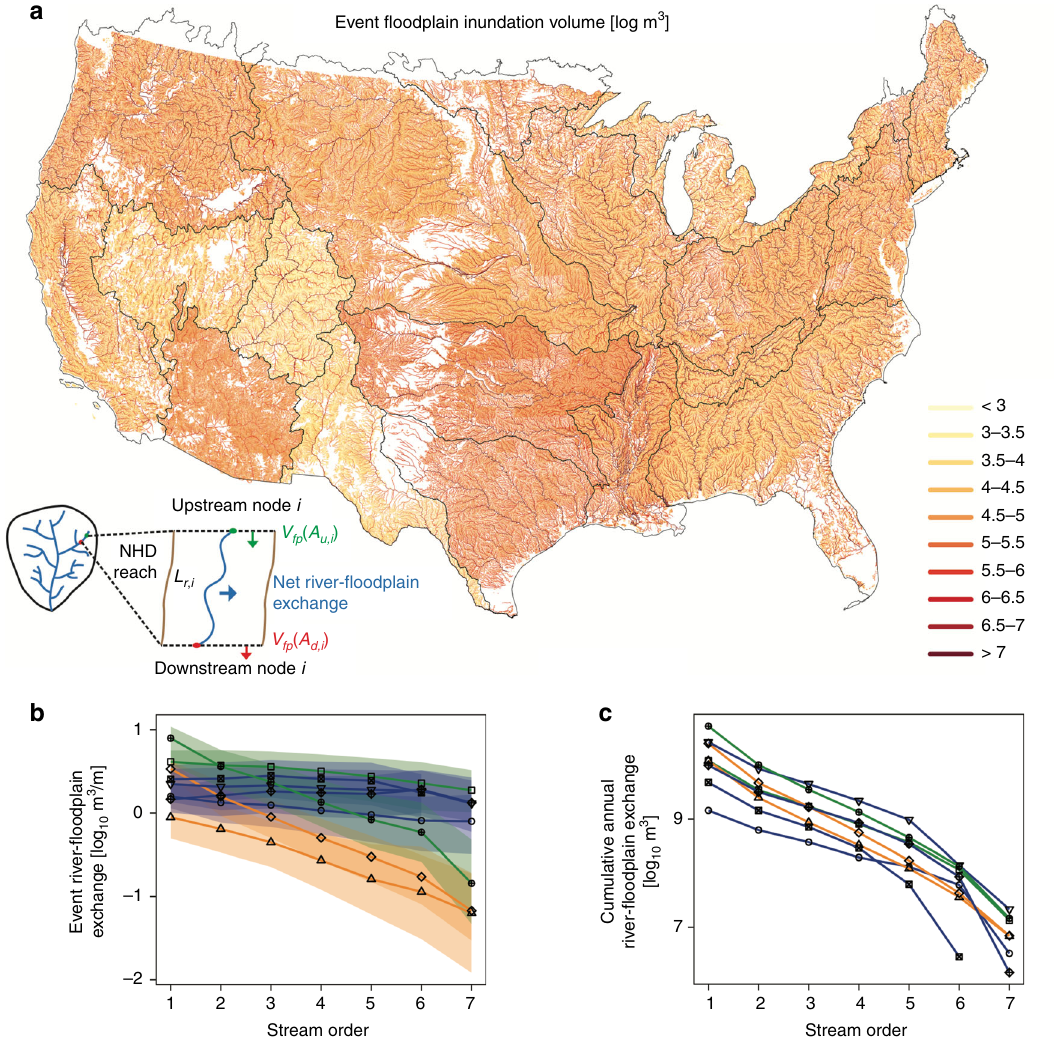
Fig. 3 Floodplain signi fi cance through river basins applied to the National Hydrography Database Plus stream network. a Event fl oodplain inundation volume [log m 3 ], with inset highlighting approach to estimate river- fl oodplain exchange per reach. b River- fl oodplain exchange during events [log10 m 3 m − 1 ] within all streams of order n across major river basin. The uncertainty bounds represent 95th con fi dence derived from the uncertainty analysis. c Cumulative annual river- fl oodplain exchange [log10 m 3 ] within each stream order across major river